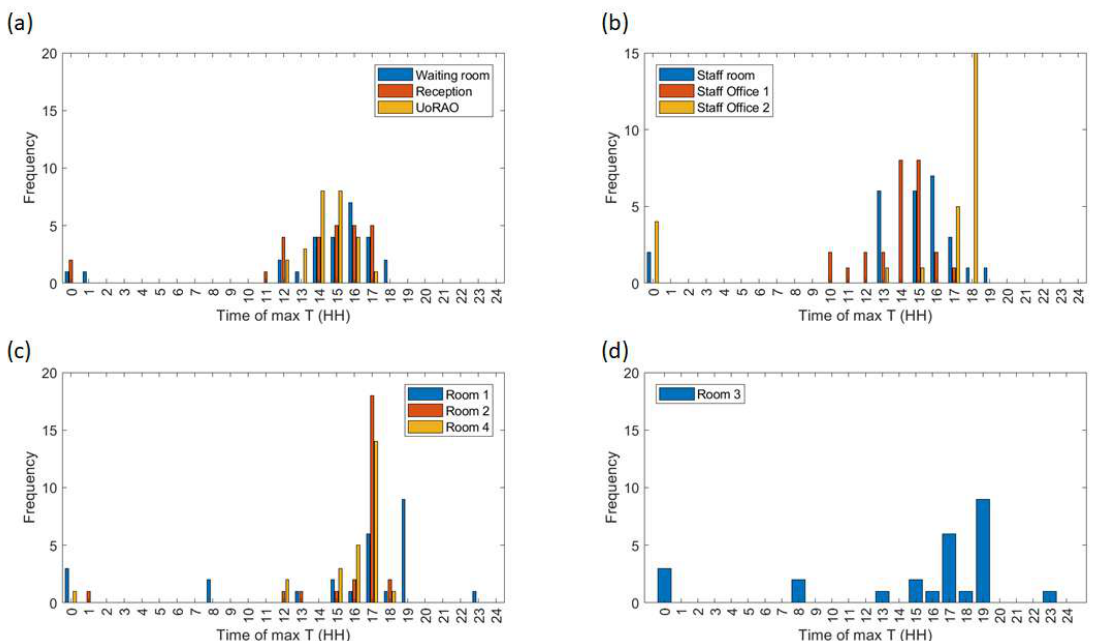
Figure 8. Hours in which the maximum daily temperatures recorded on the weekdays occur (Figure 9). For clarity, similar rooms are plotted on one subplot, (a) Waiting room, Reception and the observatory (UoRAO), (b) Staff room and Staff offices, (c) Room 1,2, 4 and (d) Room 3. All plots have the same axis.